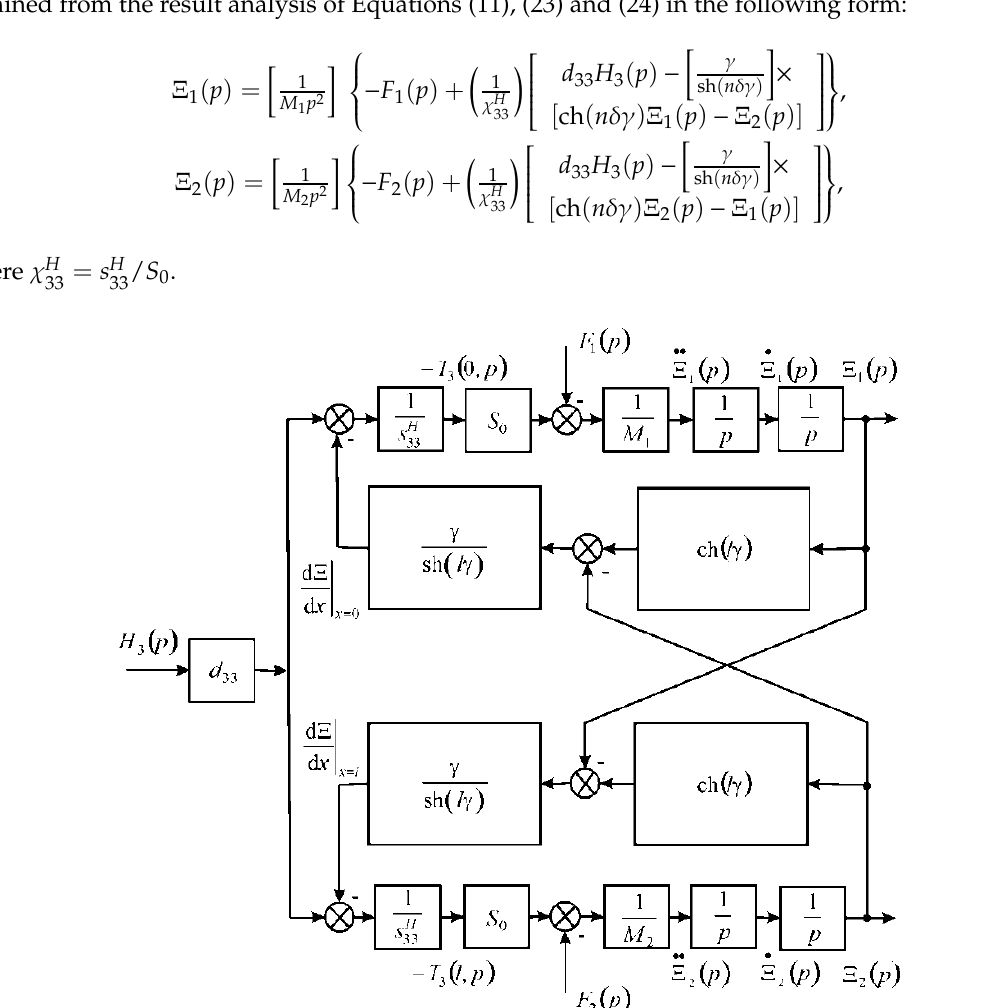
Figure 6. Parametric structural schematic diagram of multilayer magnetostrictive actuator for longitudinal magnetostrictive effect with the magnet field strength control.